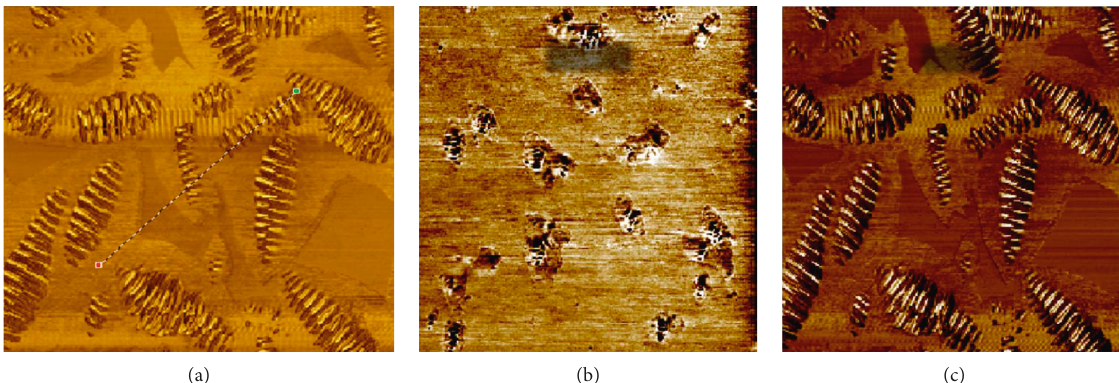
Figure 10: (a) AFM micrograph of asphalt showing catana, peri, and perpetua phases, (b) micrograph before aging, and (c) micrograph after aging. The figure is obtained from Allen [33] (under the creative commons attribution license/public domain).